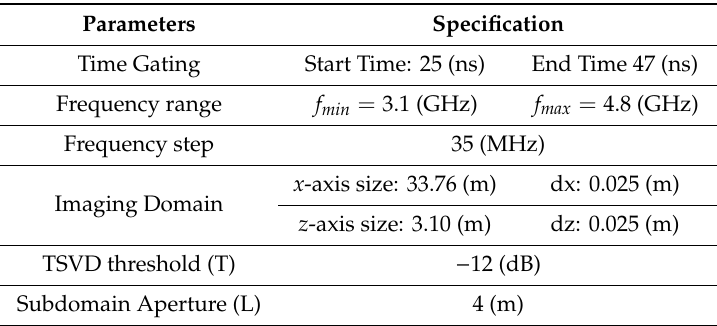
Table 6. Signal Processing Parameters: Track